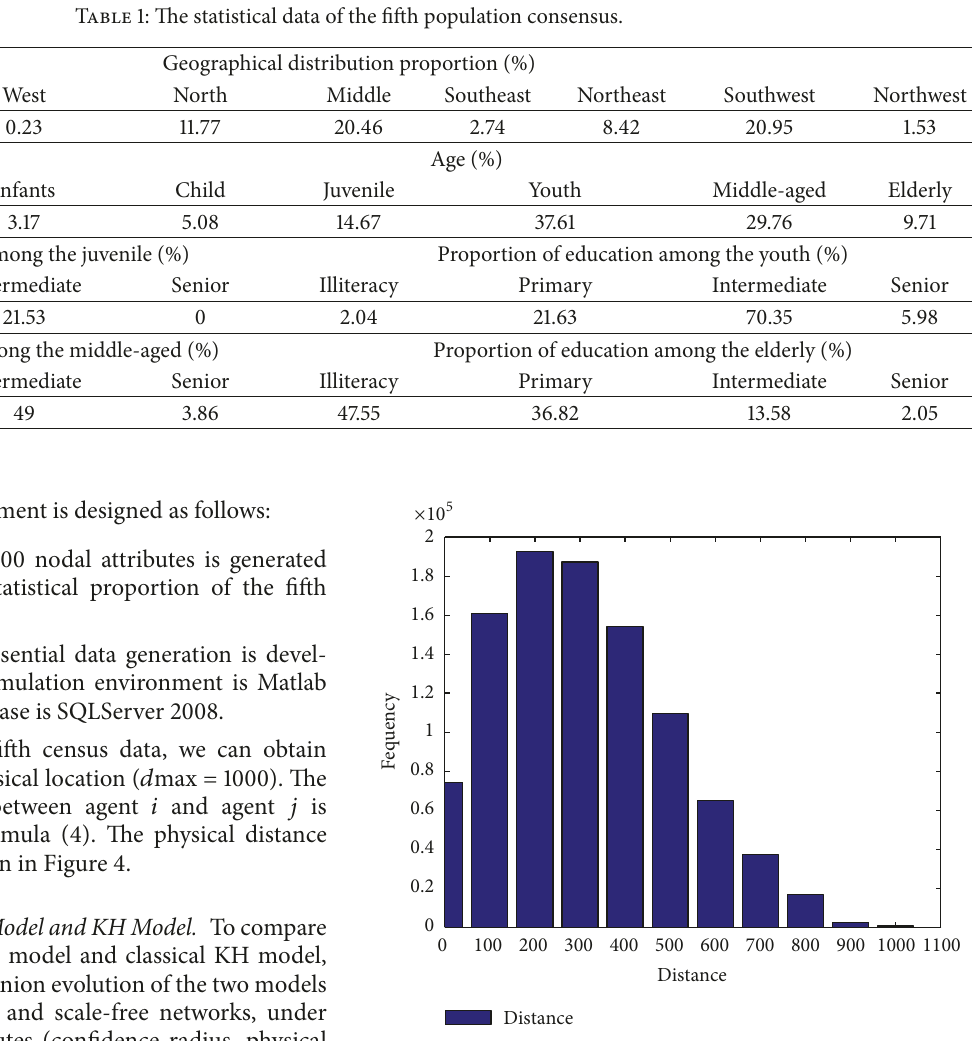
Figure 4: The physical distance